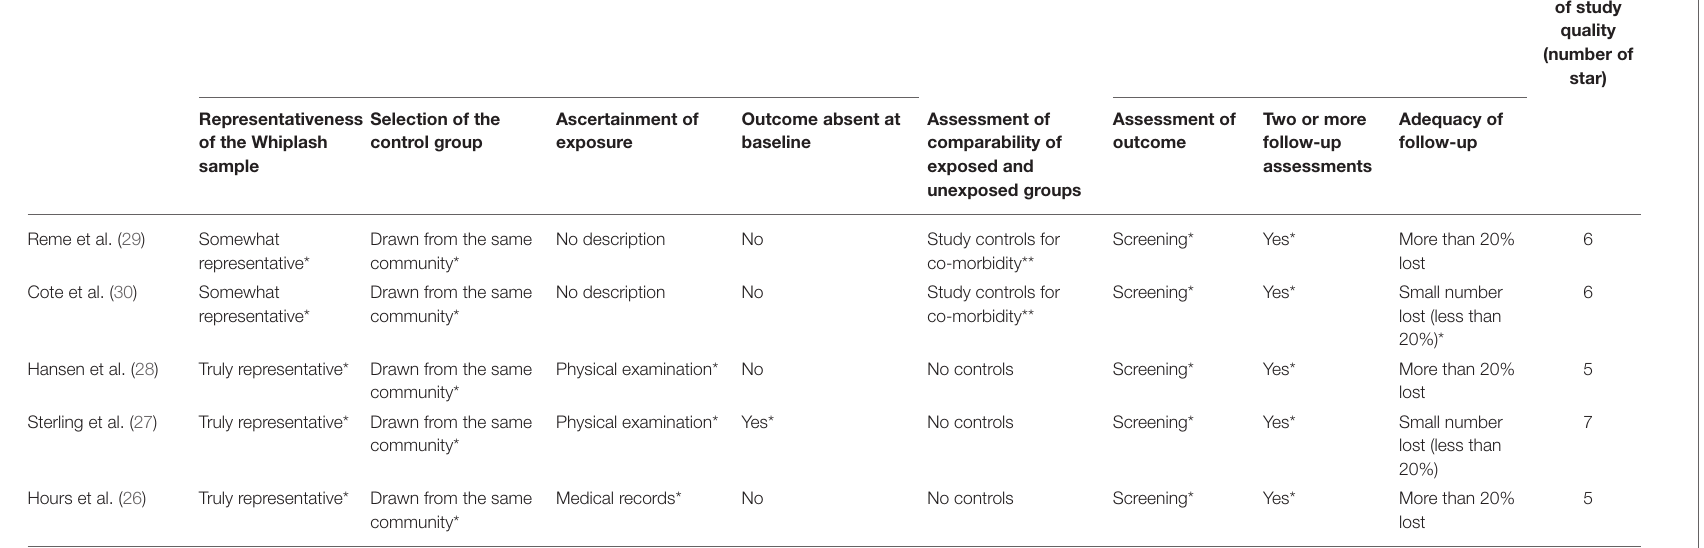
TABLE 3 | Quality assessment by Newcastle-Ottawa Scale